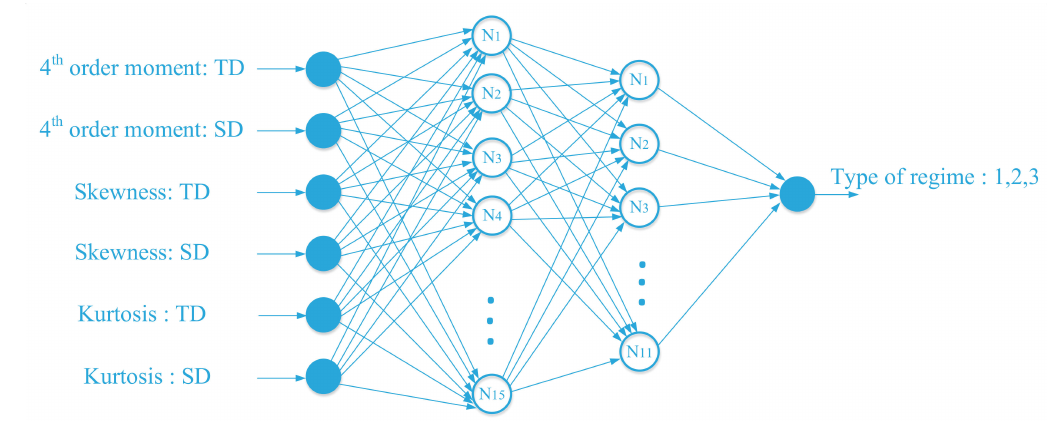
Figure 5. Structure of classifier